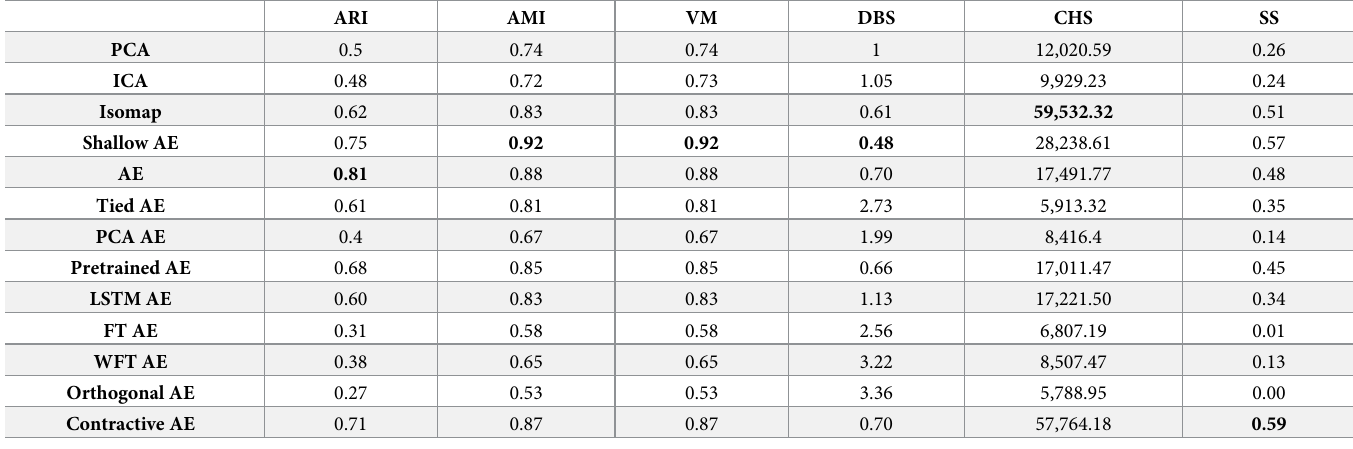
Table 6. Comparison of different autoencoder variations vs state-of-the-art methods on Sim1 (17 clusters), the optimal value of neighbours for Isomap was found as 110 through grid search. The metrics indicate that several variations of autoencoders and the Isomap algorithm are able to outperform conventional algorithms such as PCA or ICA for the Sim1 dataset that contains a high number of clusters. Moreover, two autoencoder variants outperform Isomap on 5 out of the 6 metrics, the values indicating the highest performance for each metric have been